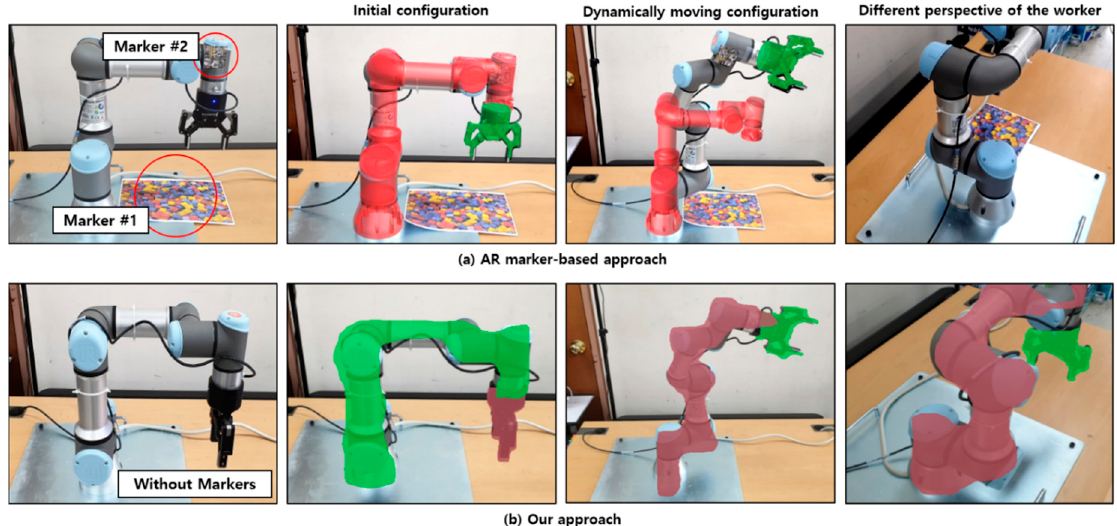
Figure 13. Handling a dynamically moving robot in AR.